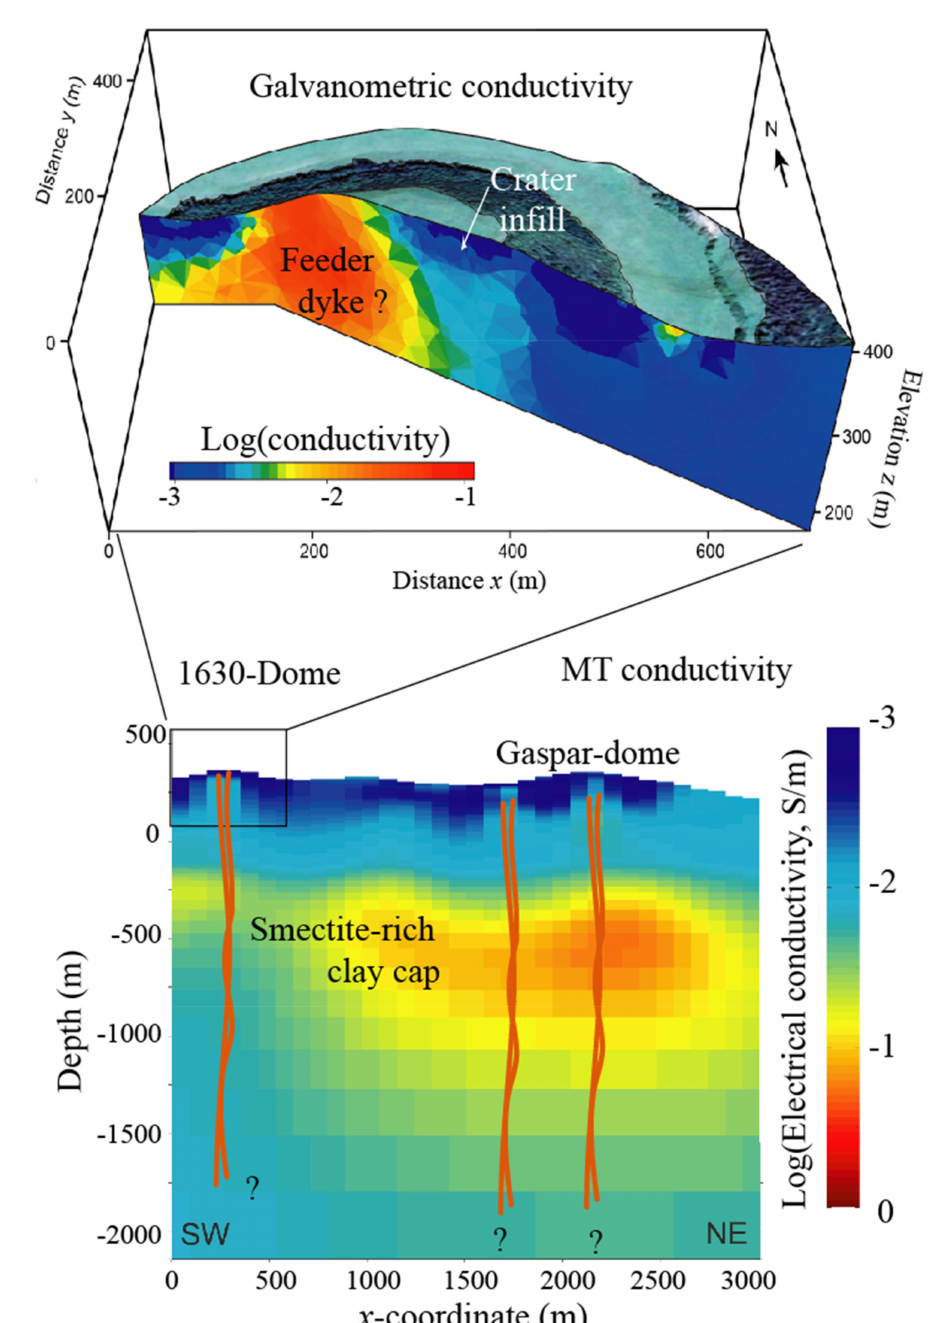
Figure 13. Detection of vents associated with monogenic domes (1630- and Gaspar domes) at Furnas volcano (San Miguel Island, Portugal). Comparison of shallow high-resolution galvanometric electrical conductivity with respect to the deeper conductivity imaging using the MagnetoTelluric (MT) method. The upper figure shows our result and the lower, Hogg et al. [91]. Note that the two cross-sections are cut at the same position of the 1630-Dome and the depths are all referenced to the sea